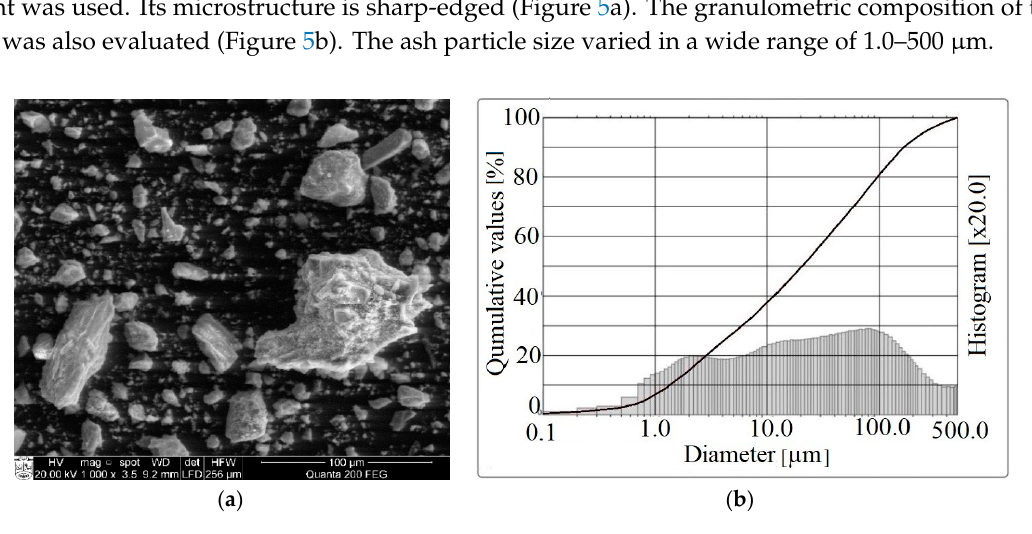
Figure 4. Fourier-transform infrared FTIR analysis of alkali-activated biomass bottom ash without zeolitic waste (0%) and with (3% and 15%) zeolitic waste.